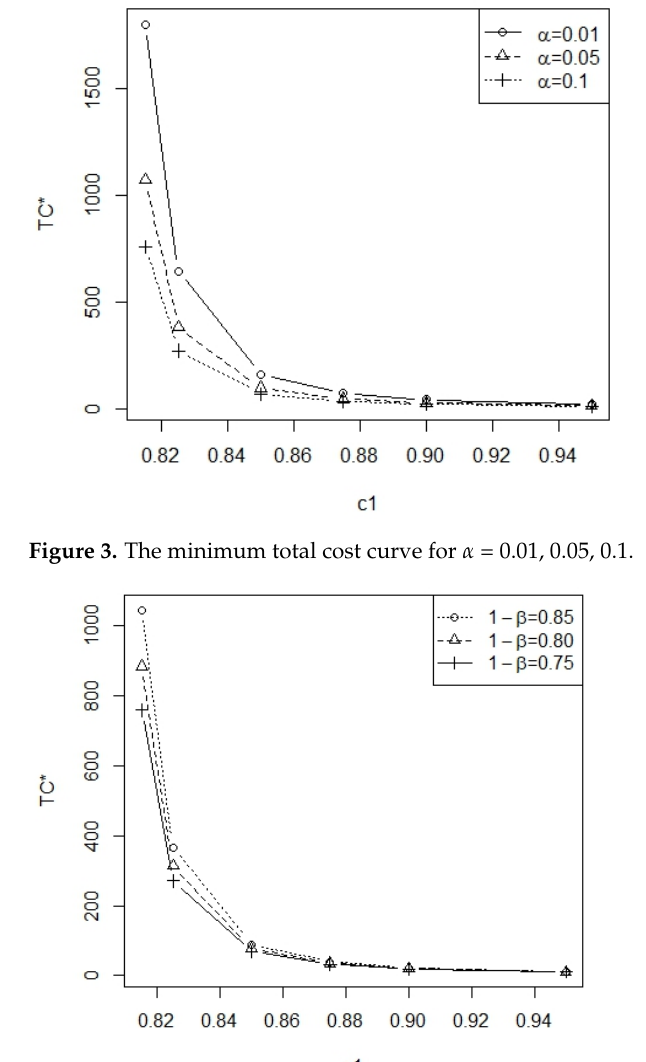
Figure 4. The minimum total cost for 1 − β = 0.75, 0.80,